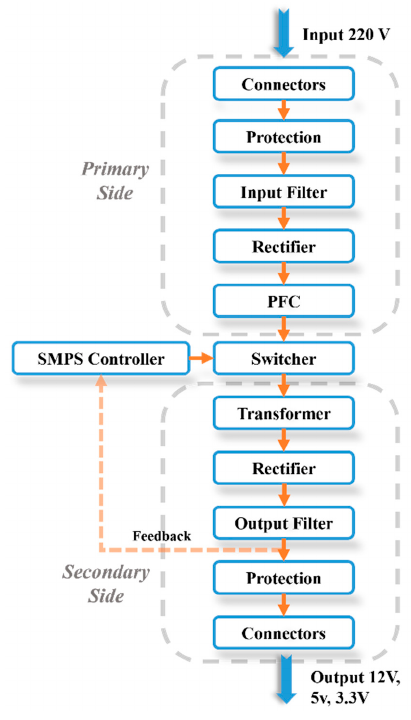
Figure 1. SMPS operation function blocks.